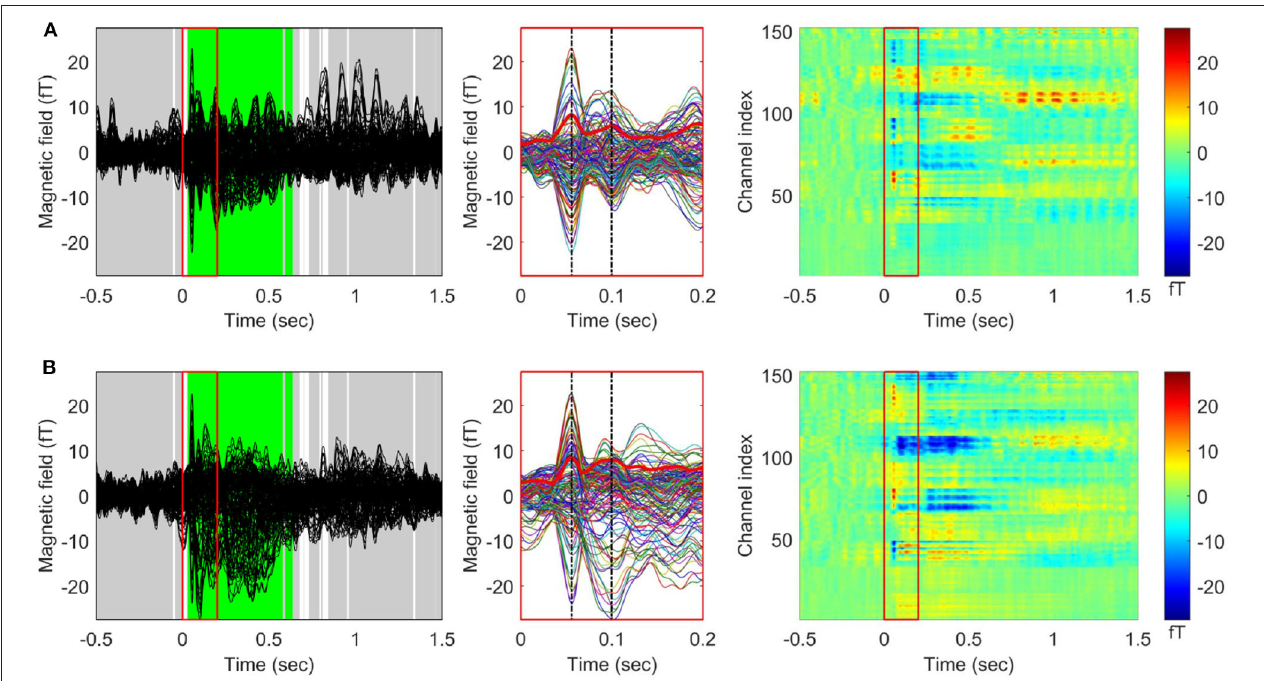
FIGURE 2 | Grand averaged event related fields (ERF) in response to vibrotactile stimulation. Butterfly plots (left panel) and 2D color plots (right panel) of the ERF waveforms averaged across 29 participants (A) for the left index finger stimulation condition and (B) for the right index finger stimulation condition. The waveforms between 0 and 0.2 s (indicated by red boxes in the butterfly plots and 2D color plots) were enlarged in the middle panel. The thick red waveforms indicate the global field power (GFP) for each stimulation condition, and the dash-dotted vertical lines (black) were drawn at the first (M50) and the second (M100) peaks of the GFP waveforms. In the 2D color plots, y-axis indicates MEG channels and the color represents the value of magnetic fields. The results of applying topographic ANOVA (TANOVA) for the comparison between the grand averaged ERFs of each condition are displayed in the butterfly plots (5,000 randomizations). The time points with a p -value above the threshold ( p > 0.05) are marked in gray while the time points with a p -value below the threshold ( p < 0.05) are marked in white. The time periods satisfying the duration criterion are shown in green [see also Kim et al. (2019) for other representation of ERFs for the right index finger stimulation